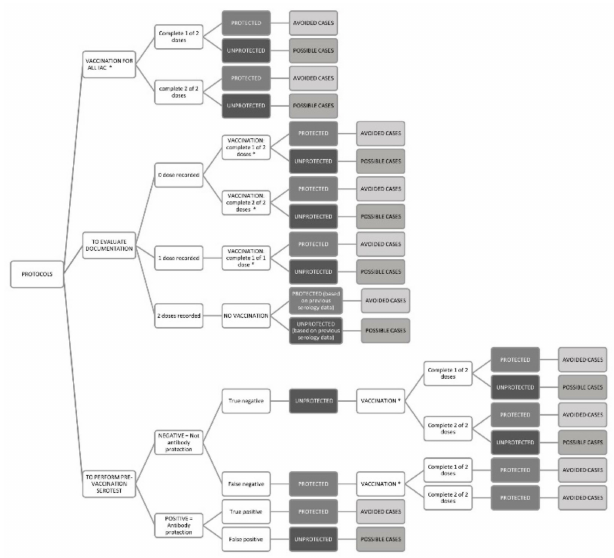
Figure 1. Decision analysis model comparing the strategy of vaccination based on documentation data against pre-vaccination serotesting or compared with presumptive vaccination with no testing. (* protected and unprotected IAC were calculated based on the compliance to the vaccination and the antibody response